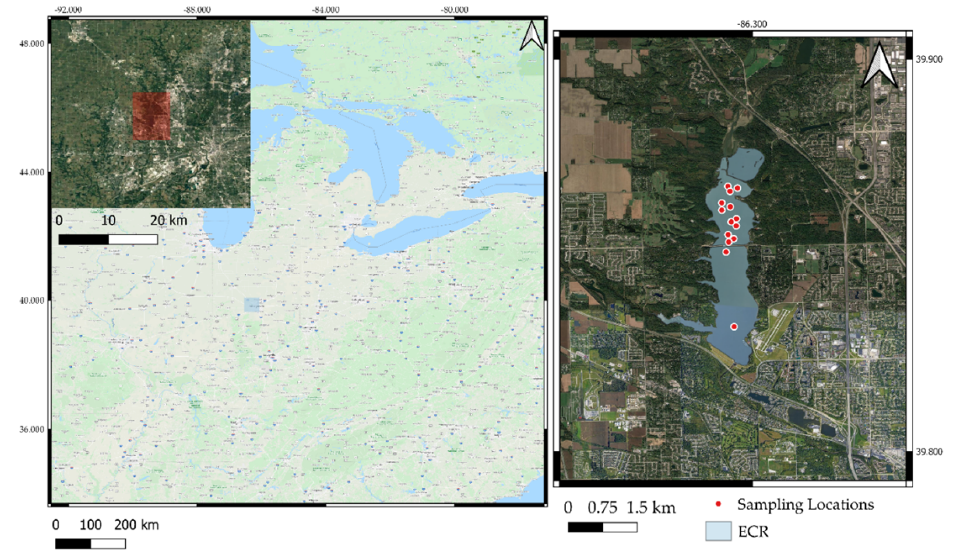
Figure 1. Location of ECR and sampling points used in this study.